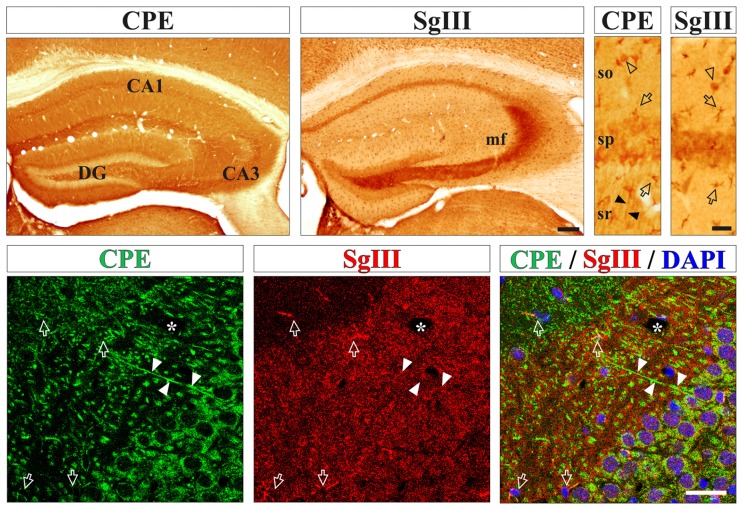
Neurons and astrocytes abundantly express carboxypeptidase E (CPE) and SgIII proteins in the cerebral cortex in vivo. Upper boxes illustrate immunoperoxidase staining for CPE and SgIII in panoramic (left) and CA1 region (right) views of the hippocampal formation. Both proteins display a remarkable area specific and laminar distribution. Neuronal CPE is primarily found in dendritic shafts (filled arrowheads) and perikarya, where mossy fibers robustly exhibit SgIII. Intense immunolabeling for SgIII and CPE is detected in astroglial cell bodies and processes (arrows). Bottom boxes show confocal images of CPE (green) and SgIII (red) double immunofluorescences in the hippocampal CA3 region. Both proteins are mainly associated with different neuronal domains. CPE is largely located in somatodendritic compartments and SgIII is mainly distributed in terminal-like buttons of mossy fibers. Intense SgIII and CPE immunofluorescences colocalize in the same astrocyte processes (arrows). Nuclei are stained in blue. Arrows and arrow-heads point to astroglial cells and interneurons, respectively. Filled arrow-heads outline dendrites and asterisk indicates blood vessels. Scale bars in μm: upper-left, 250; upper-right and bottom, 50. Abbreviations: CA, regions of the hippocampus; DG, dentate gyrus; mf, mossy fibers; so, stratum oriens; sp, stratum pyramidale; sr, stratum radiatum.